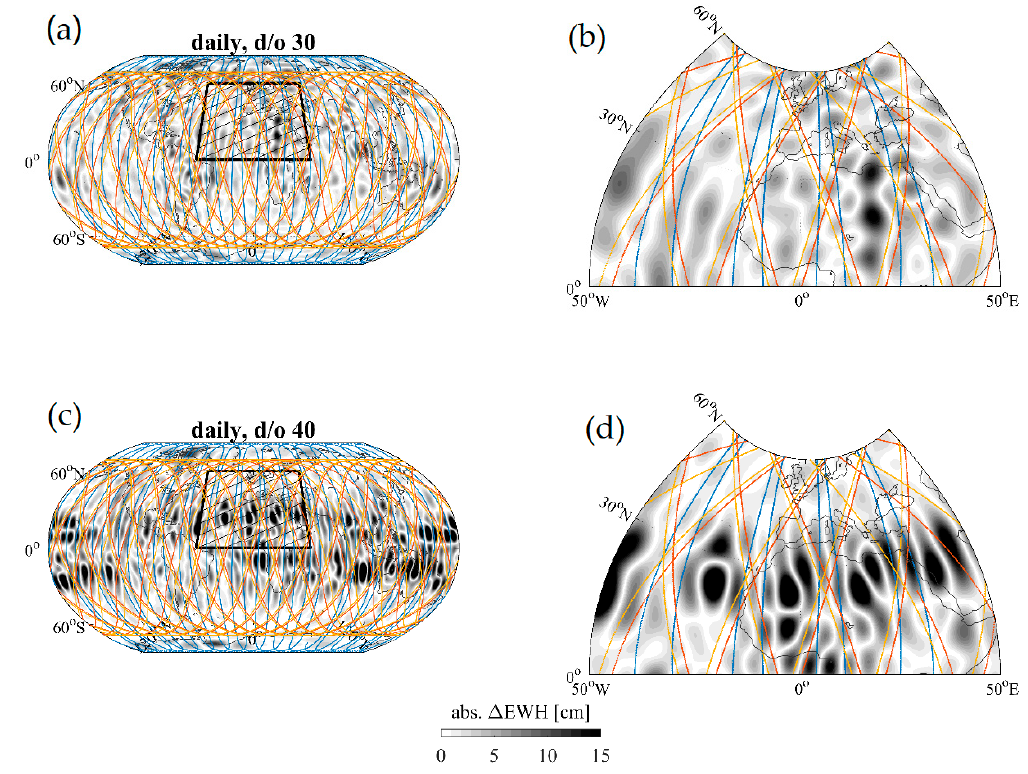
Figure 10. Spatial representation of daily solution (11 / 01 / 2002) and ground tracks. Global representation in first column, detail in column 2. ( a , b ) Solution up to d / o 30 ( c , d ); Solution up d / o 40. Omission error included.